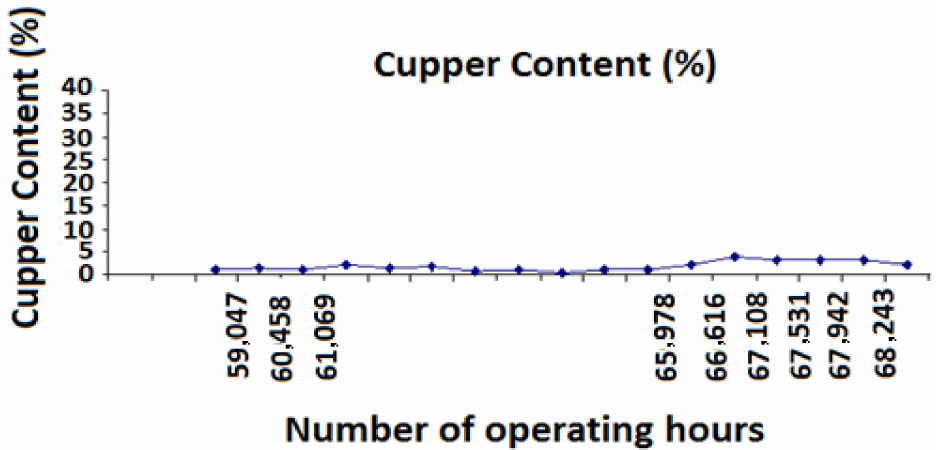
Figure 7. Copper content in lubricating oil 2016.